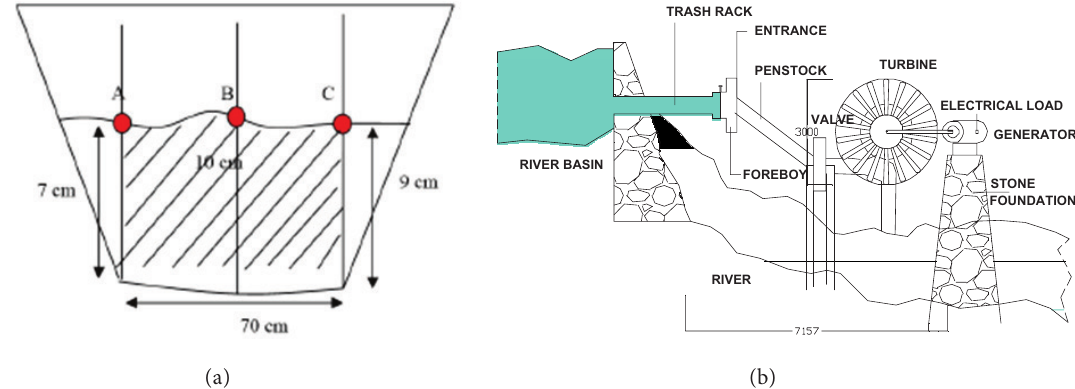
Figure 8. (a) Cross section of measurement of potential energy in the Winongo River; (b) The sample of the turbine that generates electricity for inhabitants